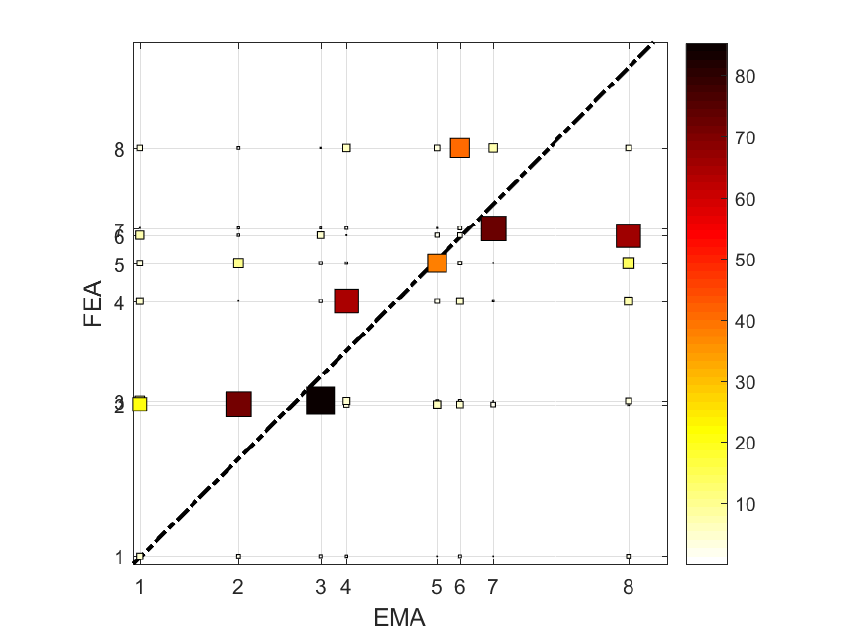
Figure 5. MACX between experimental and numerical mode